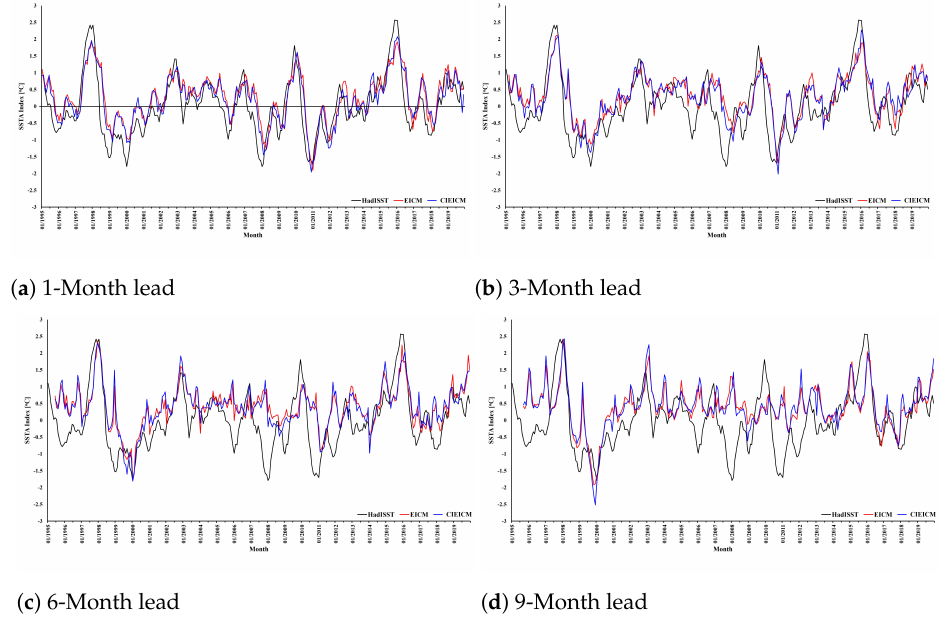
Figure 10. ENSO Phenomenon from 1995 to 2019. Table 5. Accuracy comparison between EICM, CIEICM, and HadISST